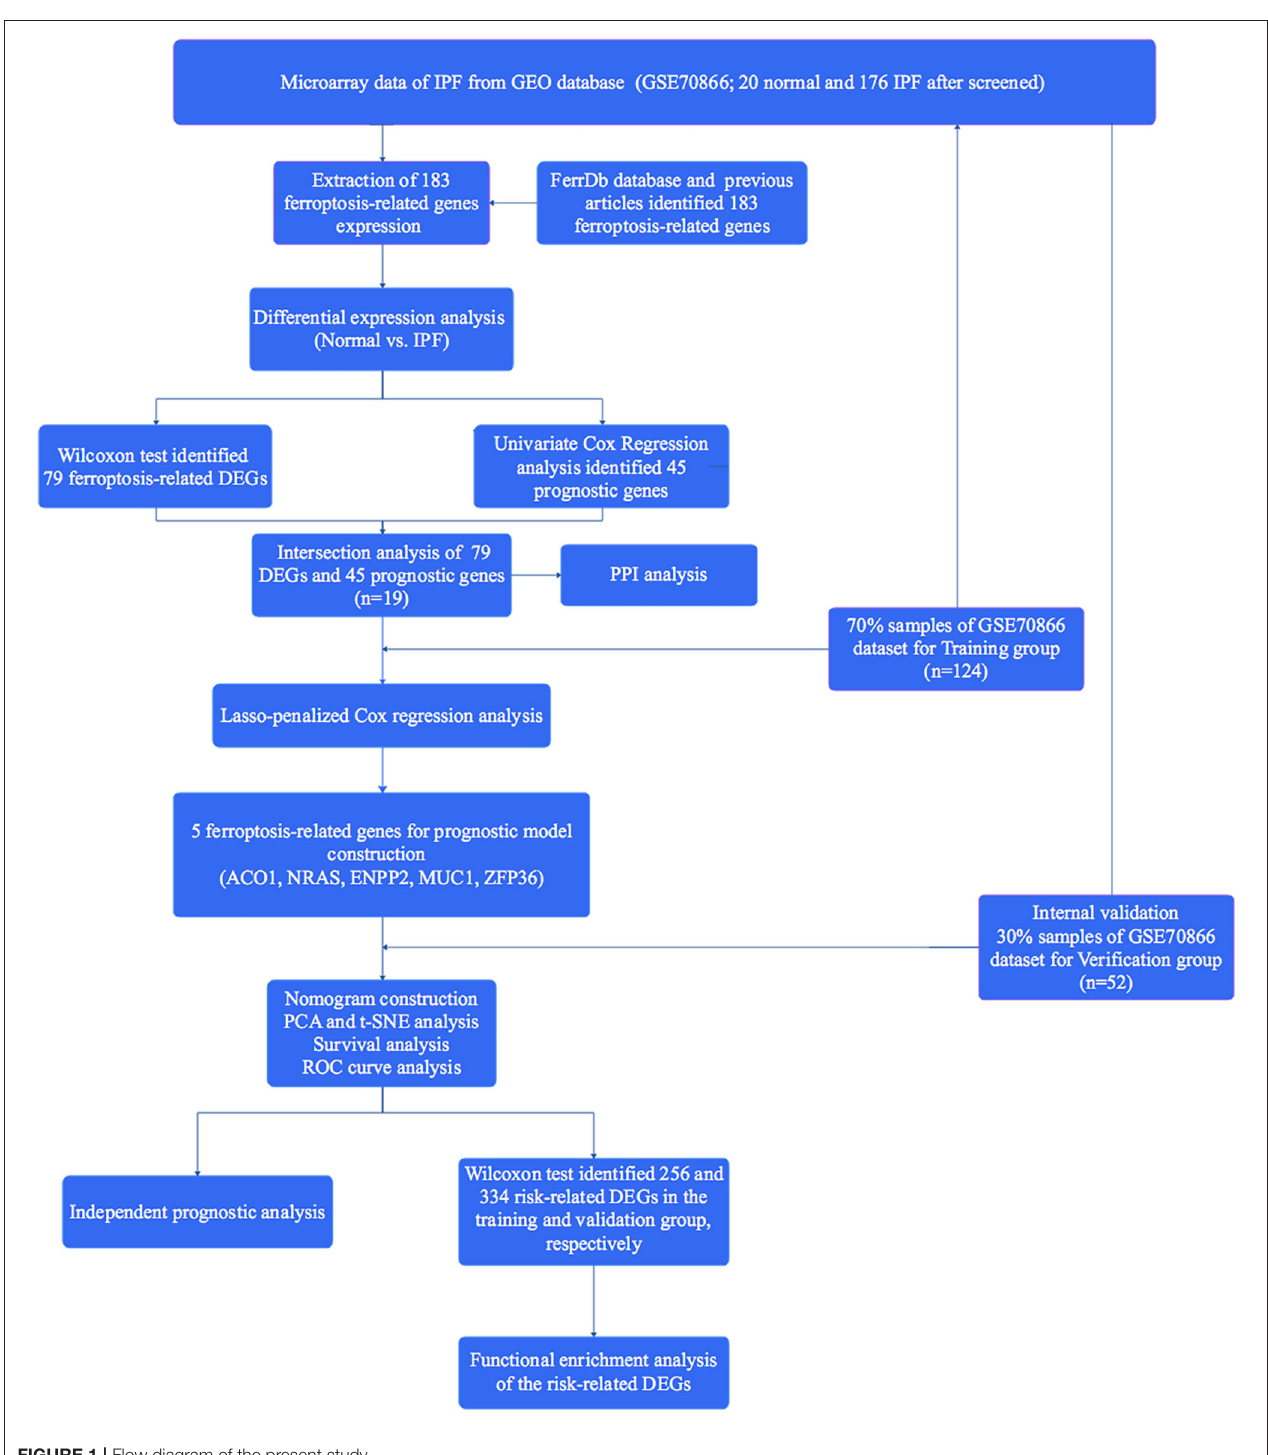
FIGURE 1 | Flow diagram of the present